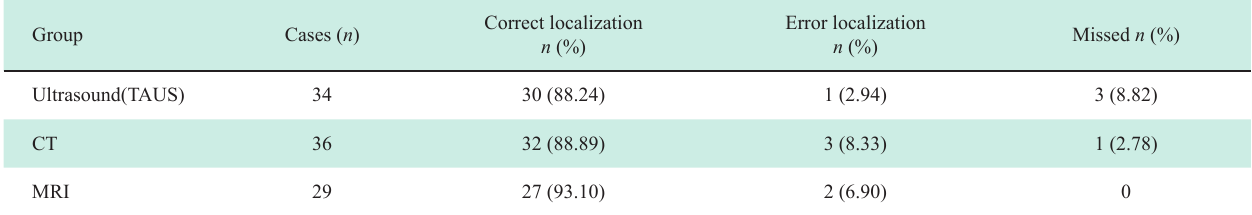
Table 3 Comparison of the localization diagnostic efficacy of transabdominal ultrasound, computed tomography, and magnetic resonance imaging Group Cases ( n )